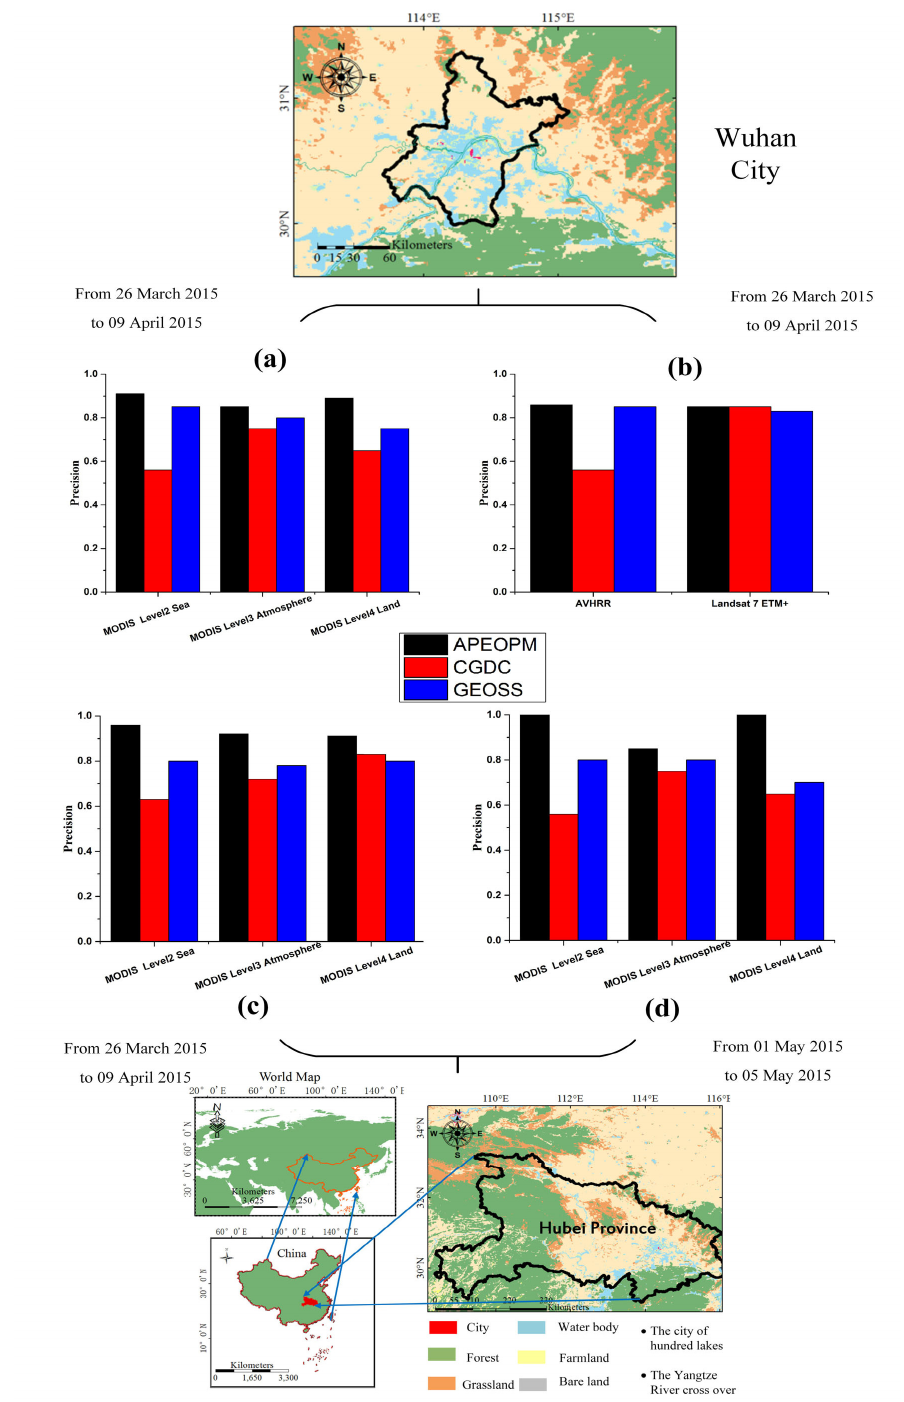
Figure 10. The top figure refers to the Wuhan City. The middle figure refers to the precision measure of Wuhan City and Hubei Province at different times. The bottom figure refers to the Hubei Province. ( a ) The precision measure of three methods retrieving MODIS products from 26 March 2015 to 9 April 2015 in Wuhan City; ( b ) The precision measure of three methods retrieving AVHRR and Landsat products from 26 March 2015 to 9 April 2015 in Wuhan City; ( c ) The precision measure of three methods retrieving MODIS products from 26 March 2015 to 9 April 2015 in Hubei Province; ( d ) The precision measure of three methods retrieving MODIS products from 01 May 2015 to 5 May 2015 in Hubei